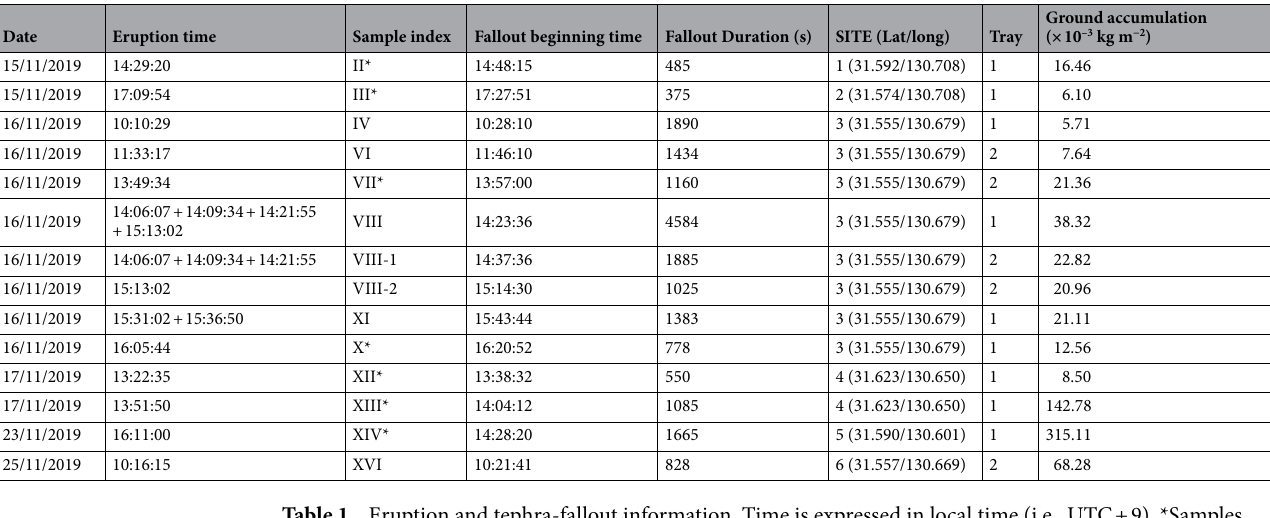
Table 1. Eruption and tephra-fallout information. Time is expressed in local time (i.e., UTC + 9). *Samples characterized also by laser diffraction by Diaz-Vecino et al. 33 .